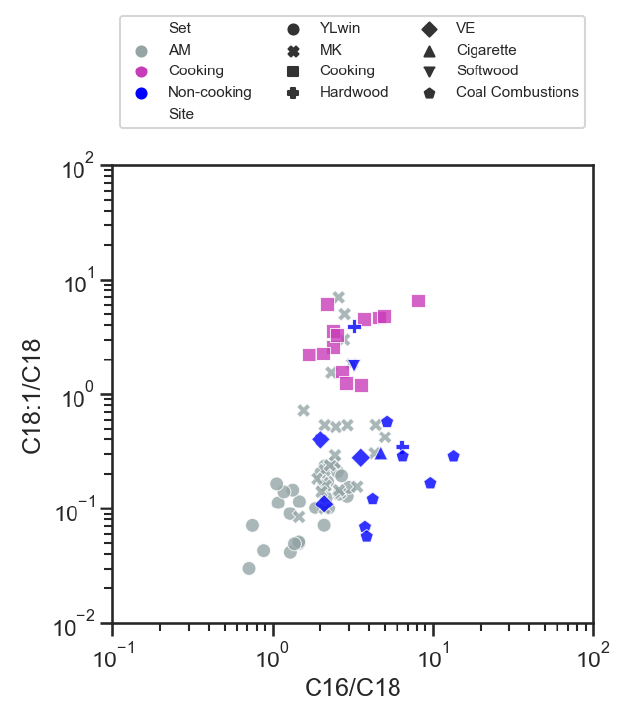
Figure 7. Ratio–ratio plots of C18:1/C18:0 against C16:0/C18:0 color coded or marked by different settings. Ambient samples (AM) are marked in grey, cooking source data in pink, and non-cooking source data in blue. VE means vehicular emissions. Cigarette, hardwood and softwood mean the combustion emissions using them as fuel.